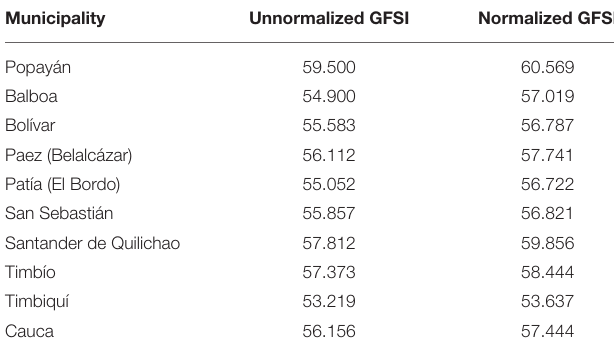
TABLE 2 | GFSI score by